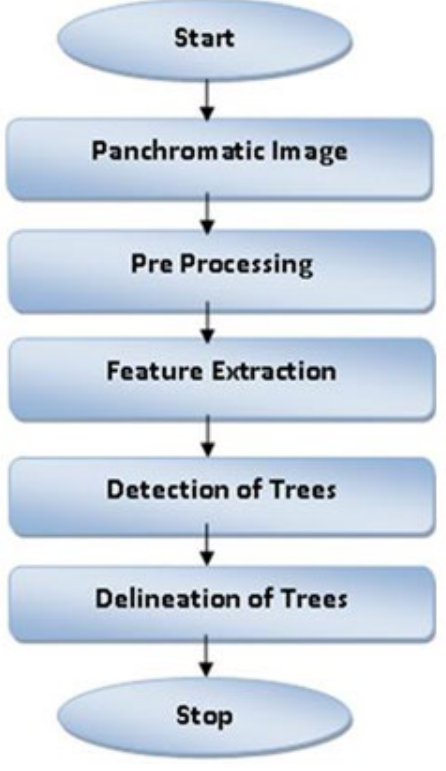
Figure 1. Overview of Proposed Methodology